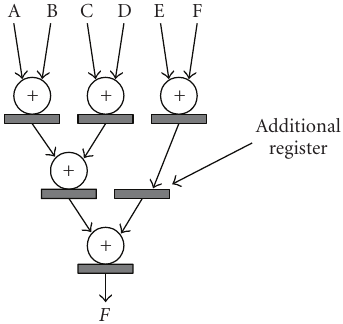
Figure 7: The fastest possible tree is formed and a synchronizing register is inserted, such that new values for the inputs can be read in every clock